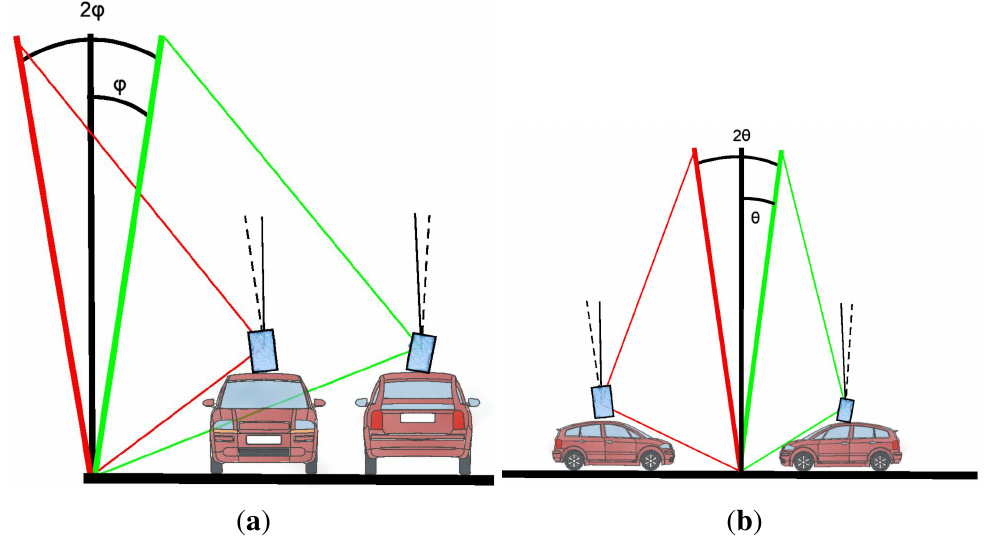
Figure 4. Configuration for the calibration of pitch and roll angles; for both angles,